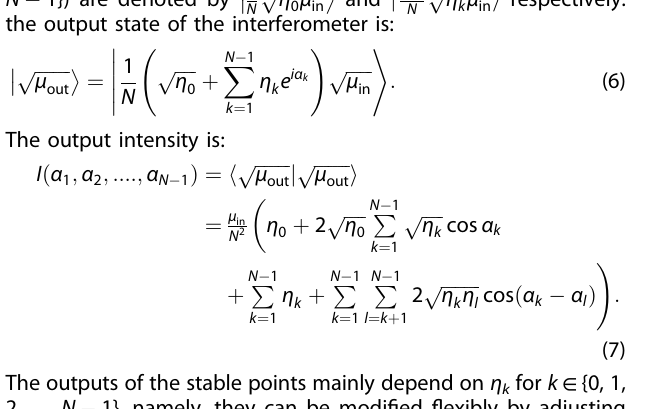
the output state of the interferometer is: ffiffiffiffiffiffiffiffi p (cid:3) (cid:3) μ out